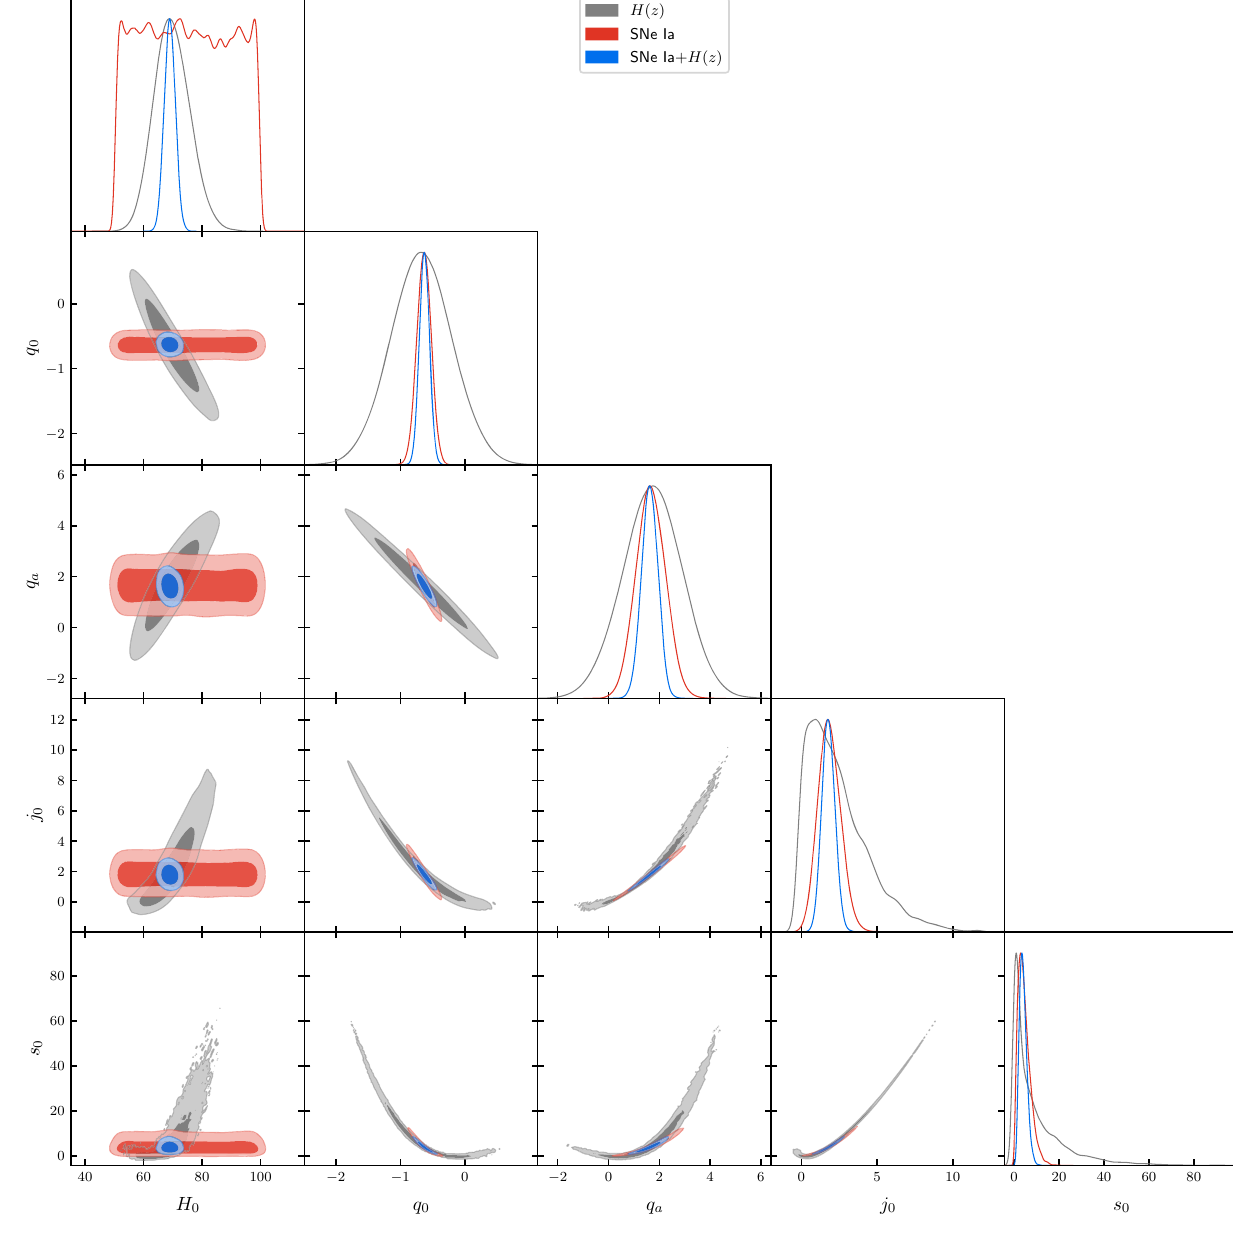
Fig. 3 M2: q ( z ) = q 0 + q a ( 1 − a )